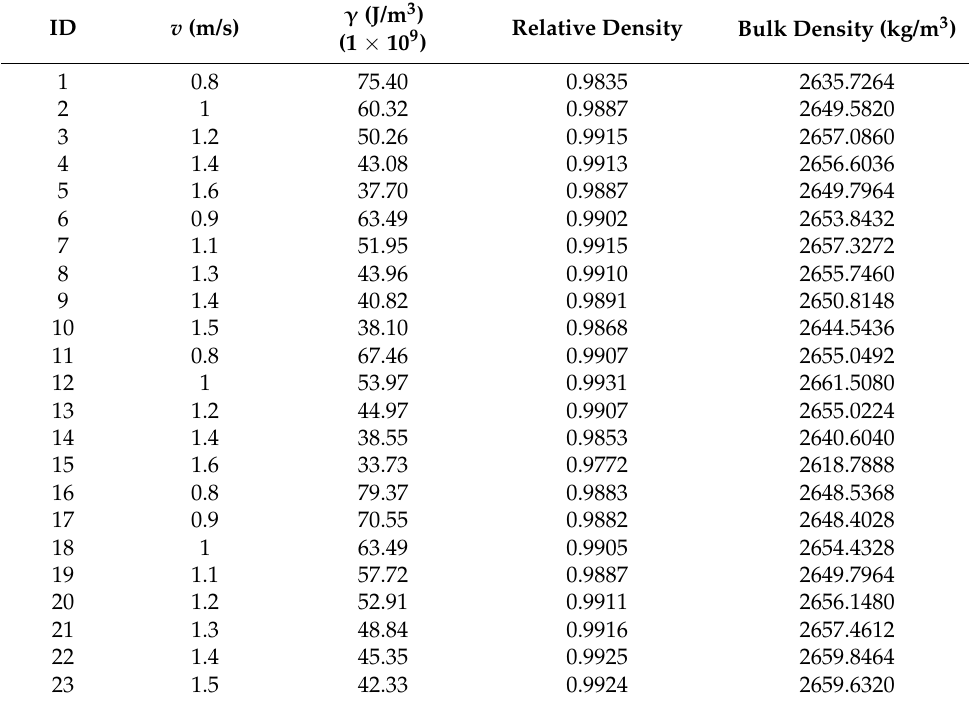
Table 10. Parameter values used to AM AlSi10Mg alloy samples. Experimental data taken from [59].